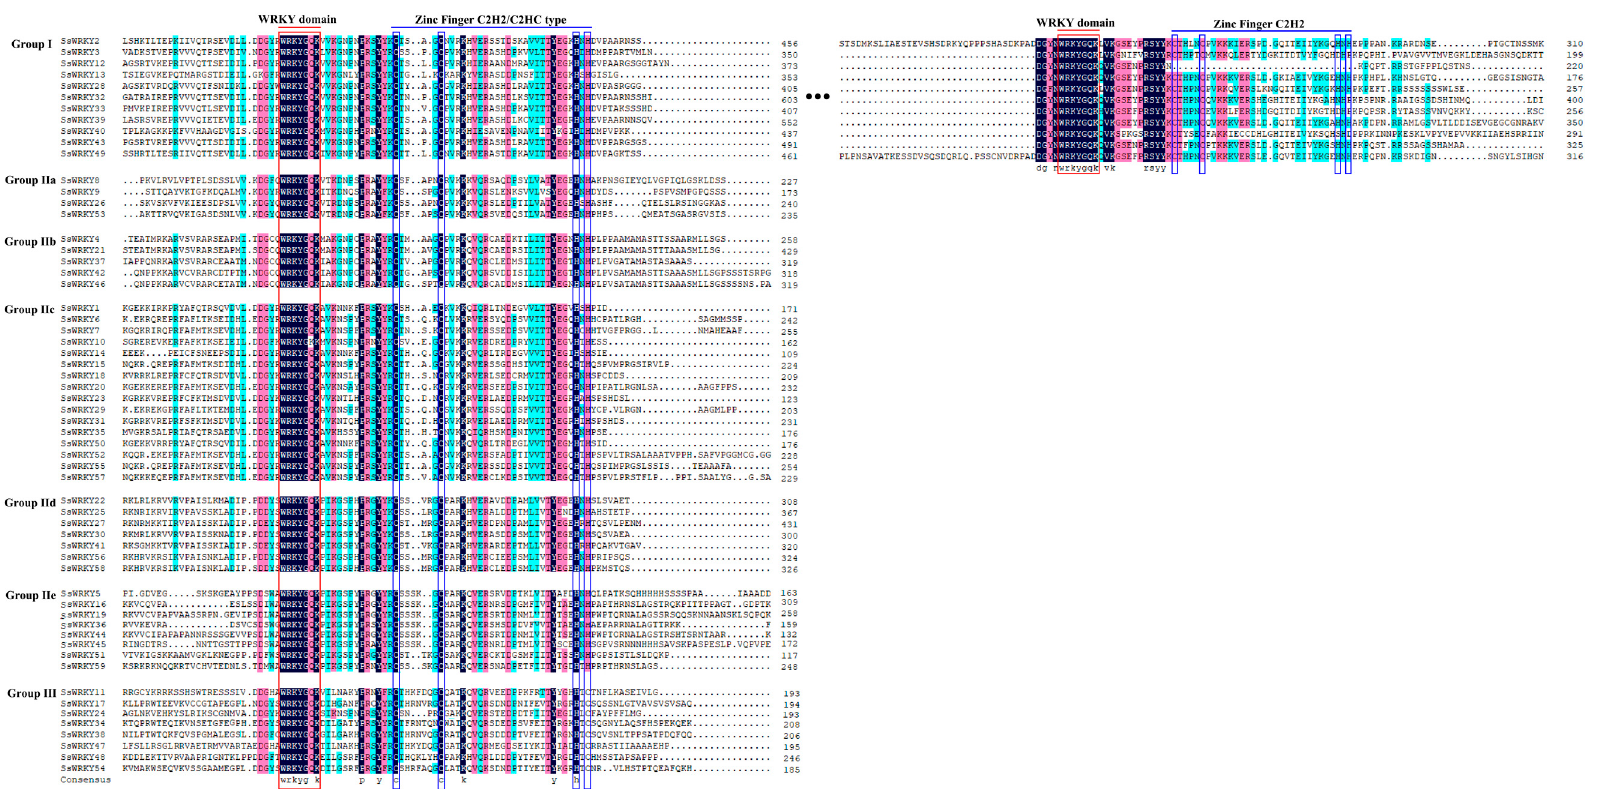
Figure 2. Multiple sequence alignments of the WRKY domain amino acid sequences of 59 SsWRKY proteins, visualized using the DNAMAN7.0 program. The highly conserved regions in each groups are shown in dark blue. The red lines represent the WRKY domains, and the blue lines indicate the conserved zinc finger motifs.